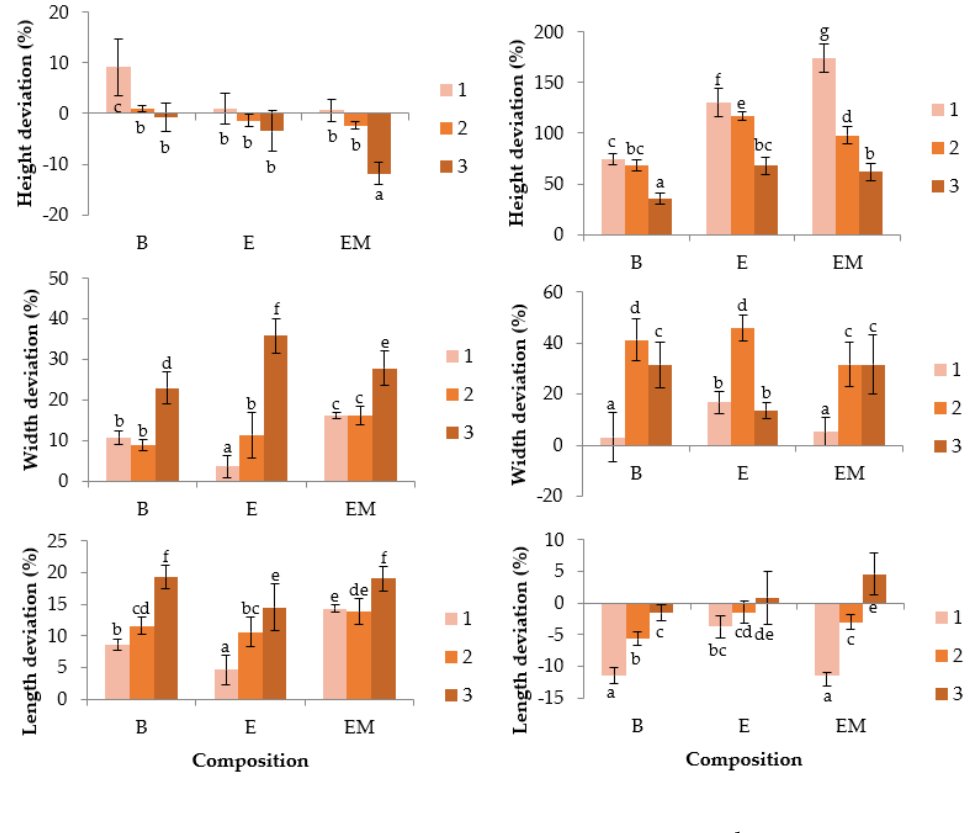
Figure 1. ( a ) Deviations of the proportions of the recently printed samples; ( b ) Deviations of the proportions of the samples after baking (B: control; E: rose hip; EM: rose hip maltodextrin; 1, 2, 3: height cm). Letters (a – g) indicate homogeneous groups according to ANOVA ( p < 0.05).